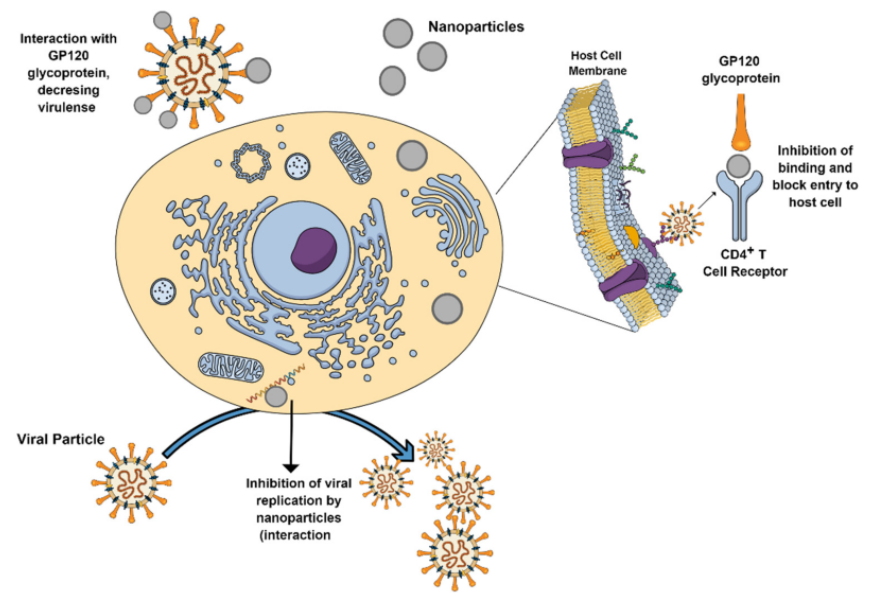
Figure 11. The possible mechanisms by which nanoparticles can act against different viruses. Copied from MDPI [210].